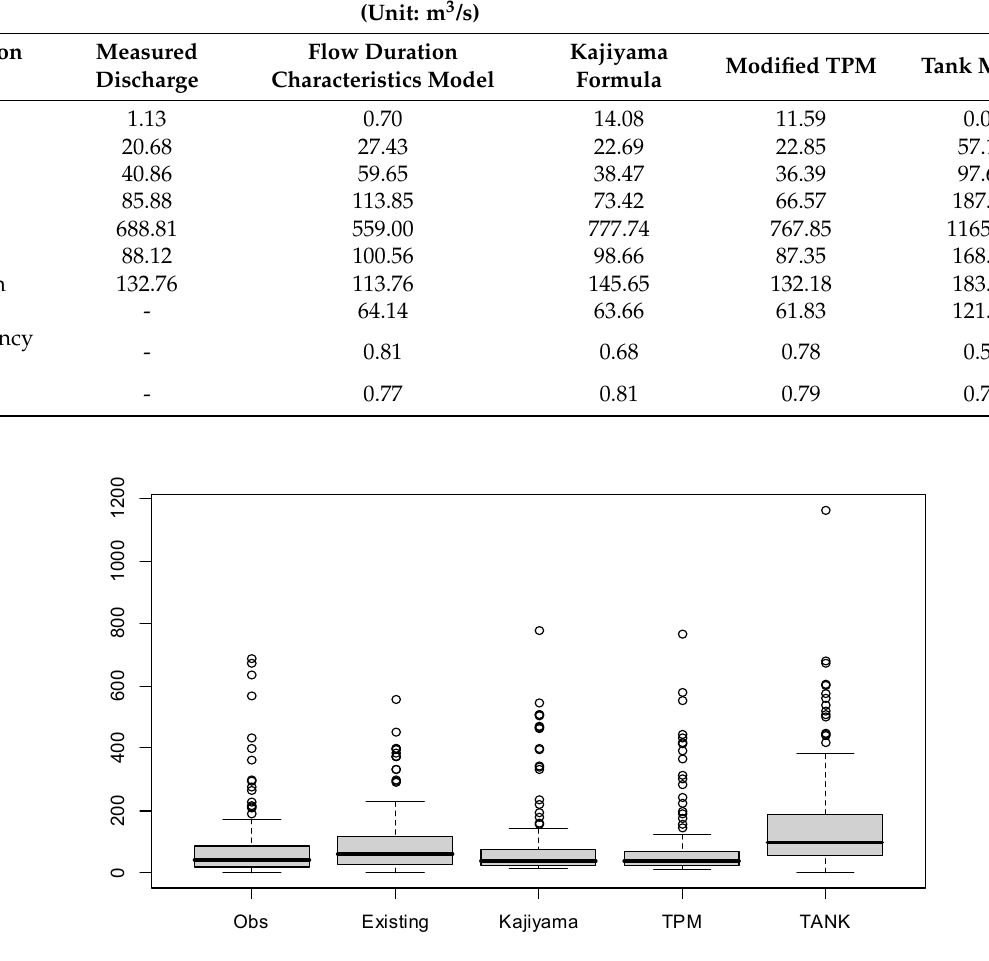
Figure 3. The distributions of the simulated and measured monthly average discharge by the Figure 3. Th e distributions of the simulated and measured monthly average discharge by the simulation method for the Hanseok SHP plant (unit: m 3 simulation method for the Hanseok SHP plant (unit: m (cid:2871) /s ).